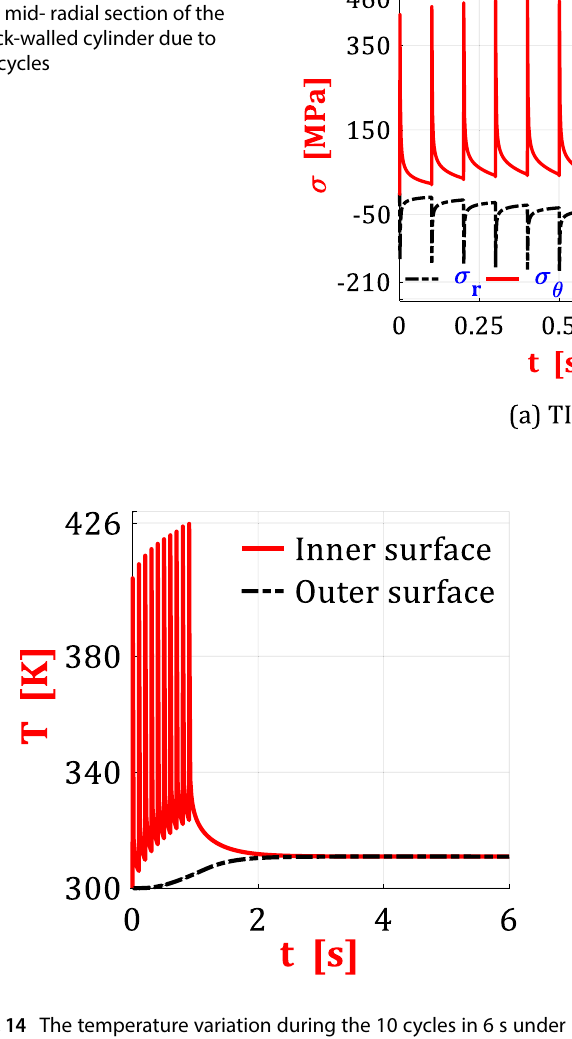
Fig. 13 Stresses-time history at the mid- radial section of the thick-walled cylinder due to 10 cycles